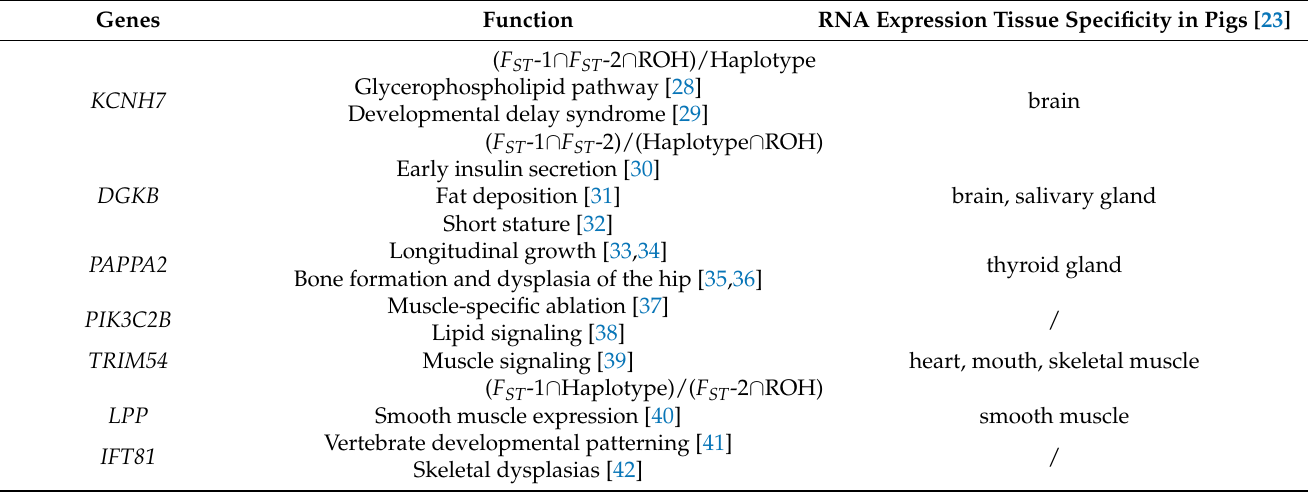
Table 2. Candidate genes in Licha black pigs that have been verified by previous studies, and the tissues with specific RNA expression in